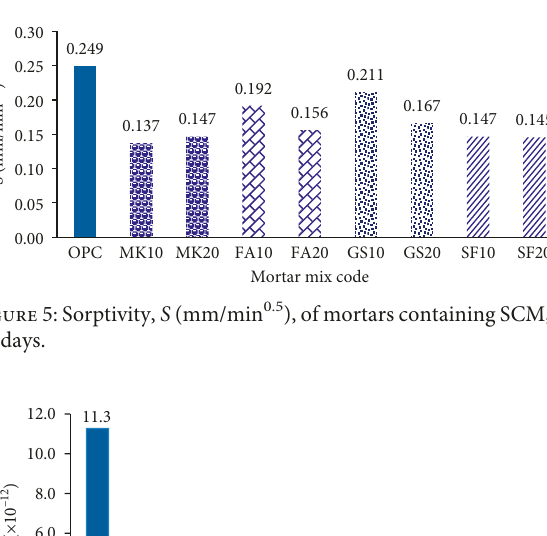
Figure 6: Chloride ion penetration coefficient D (m 2 /s) of the mixtures containing